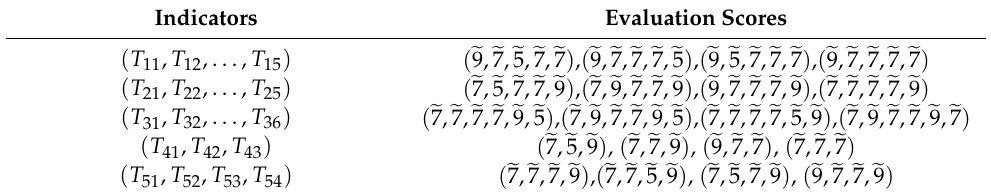
Table 3. A teacher’s scores on the sub-indicators given by four of his students. Indicators Evaluation Scores